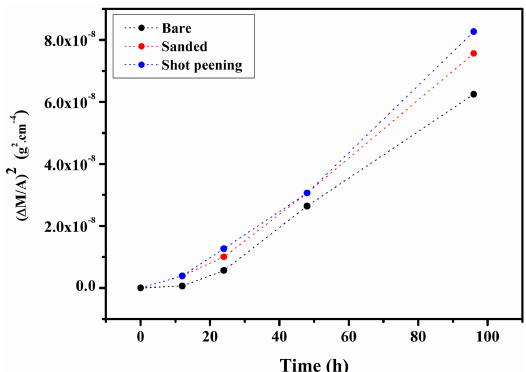
Figure 7. Oxidation test at temperature of